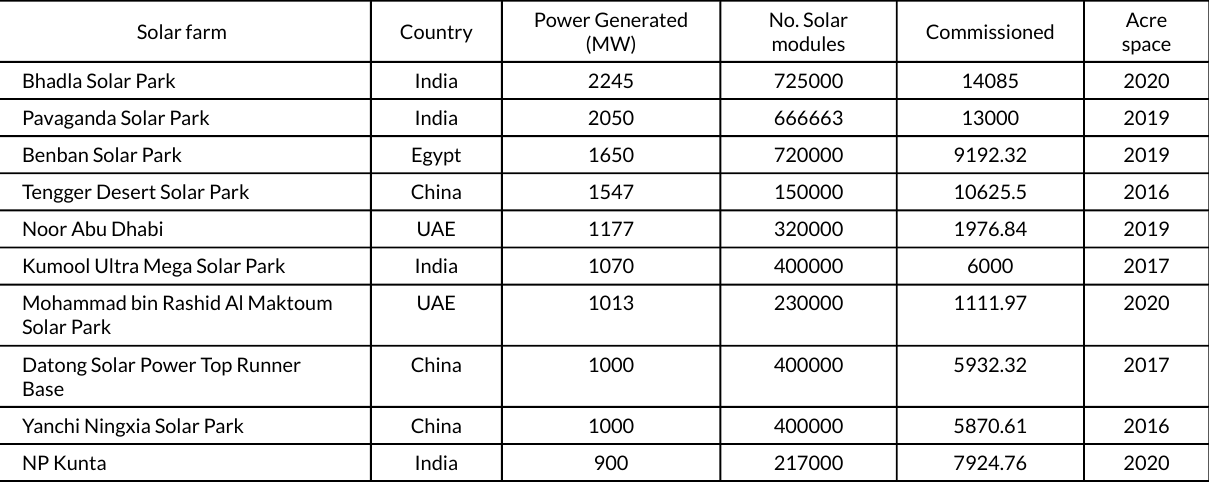
Table 3. The largest ten solar power plants in the world